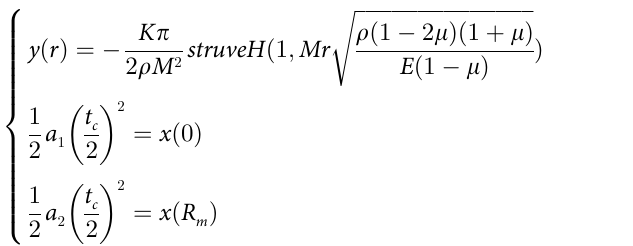
Table 3. Parameters applied in sensors distribution by LCSO.